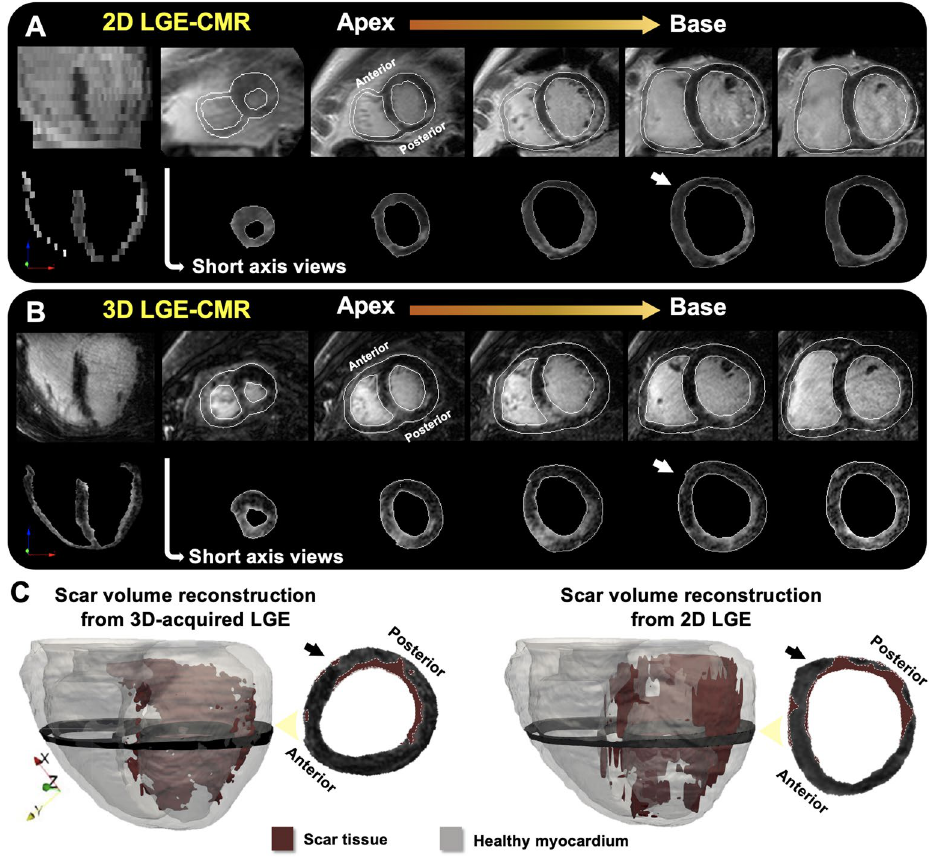
Figure 2. Myocardial segmentation and generation of patient-specific scar-volume reconstructions in 3D models. ( A , B ) Identification and segmentation of the endocardium and epicardium of 2D ( A ) and 3D ( B ) LGE- CMR sequences from the same patient after initial automatic processing and fine manual segmentation. ( C ) Representative 3D models with scar volume reconstructions obtained from 2D and 3D LGE-CMR sequences in ( A ), ( B ). Acquisition shifts in 2D slices were corrected using the contours of the 3D-acquired